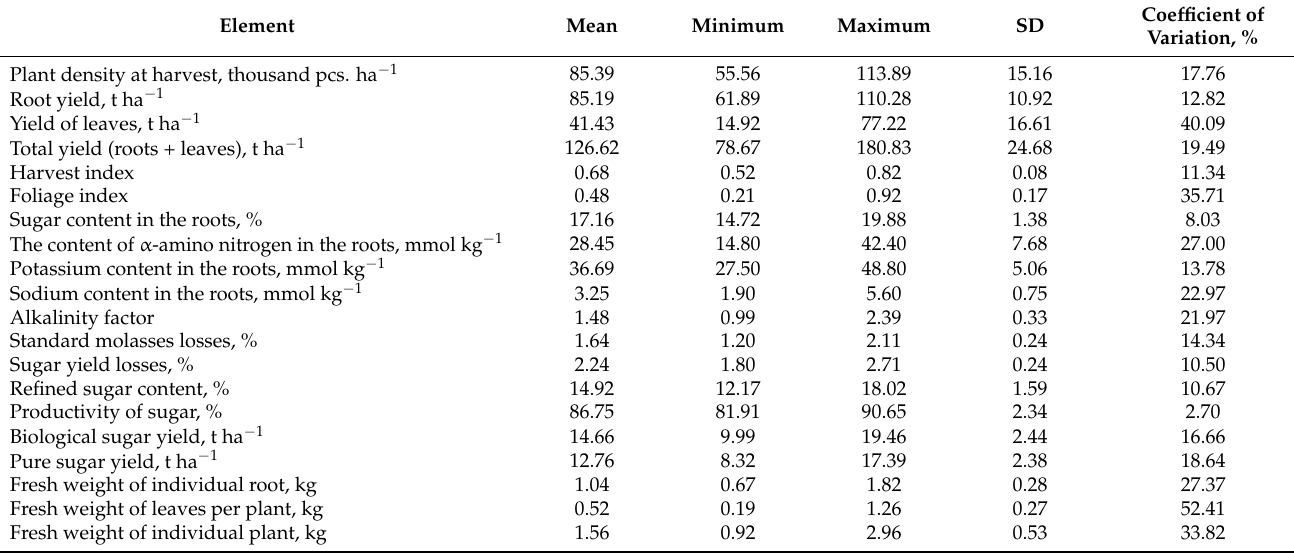
Table 5. Basic statistics for the studied traits of sugar beet in years 2018–2020 for all treatments together. Element Mean